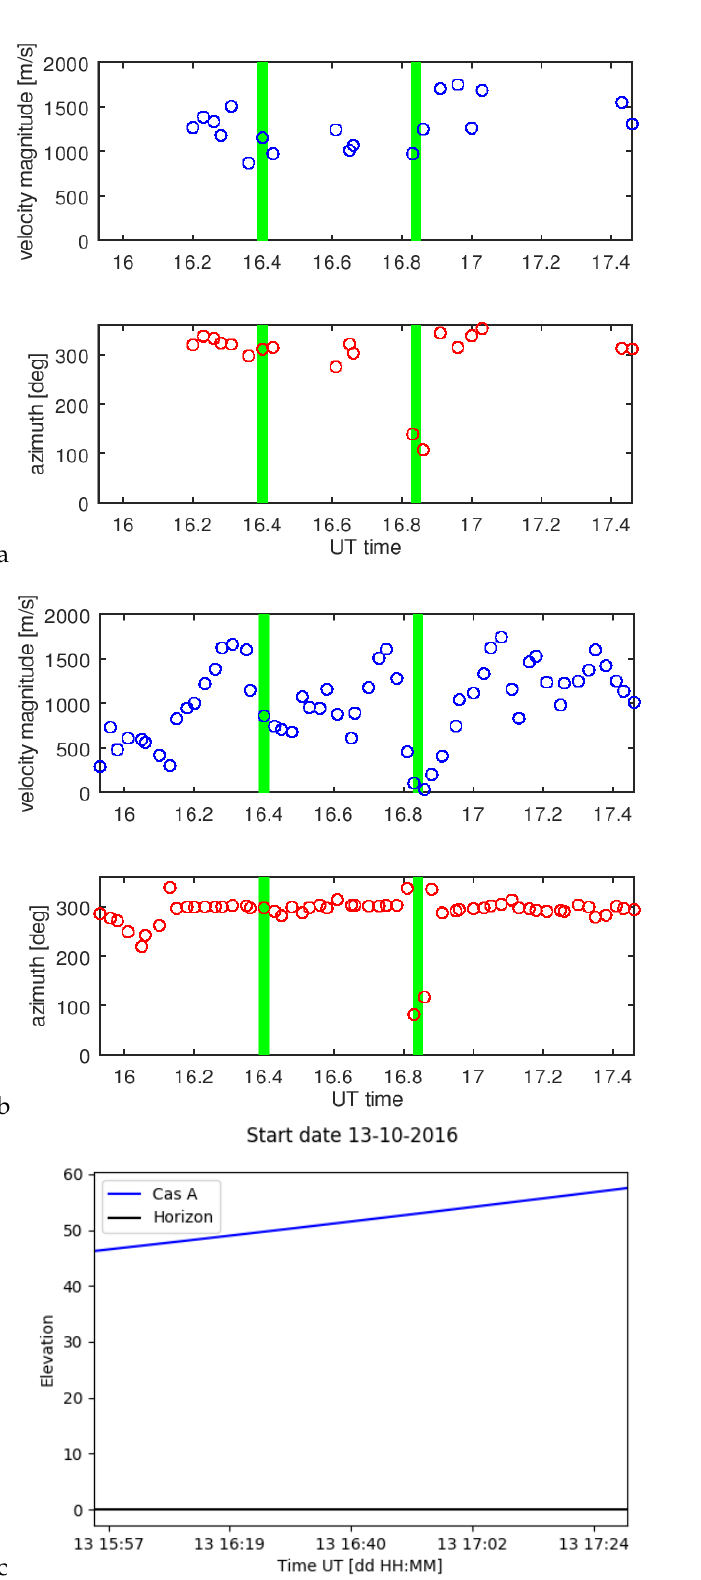
Figure 19. The drift velocity magnitude and azimuth as a function of time for the L552177 dataset for two estimators: (12)—( a ) and (20)—( b ); panel ( c ) shows the elevation of the